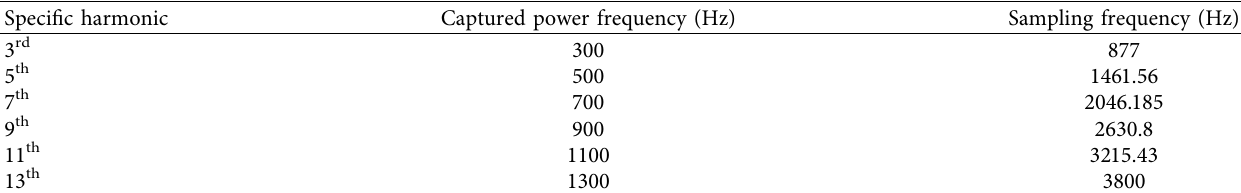
Table 1: Comparative analysis at the 1 st level of decomposition between pseudo-frequency and sampling frequency. Specific harmonic